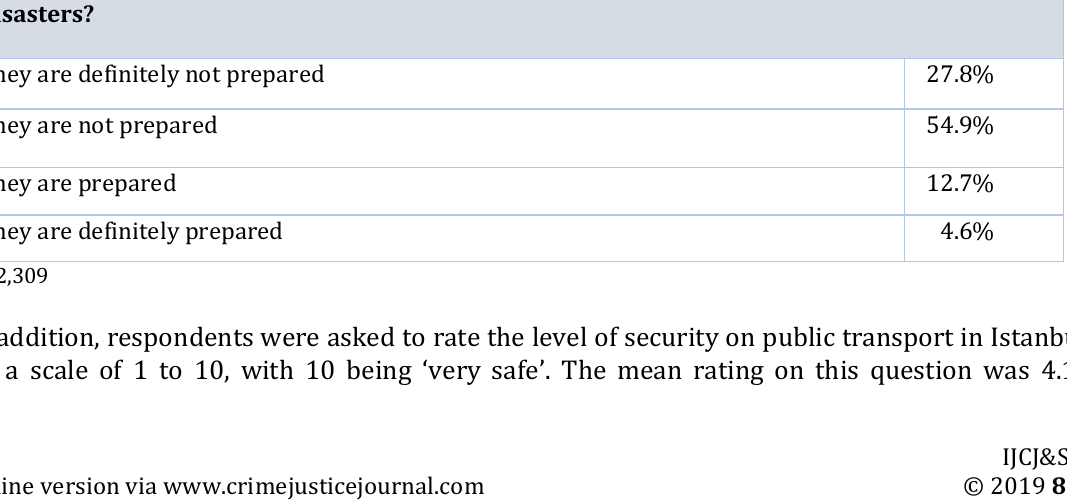
Table 5: Public institutions and natural